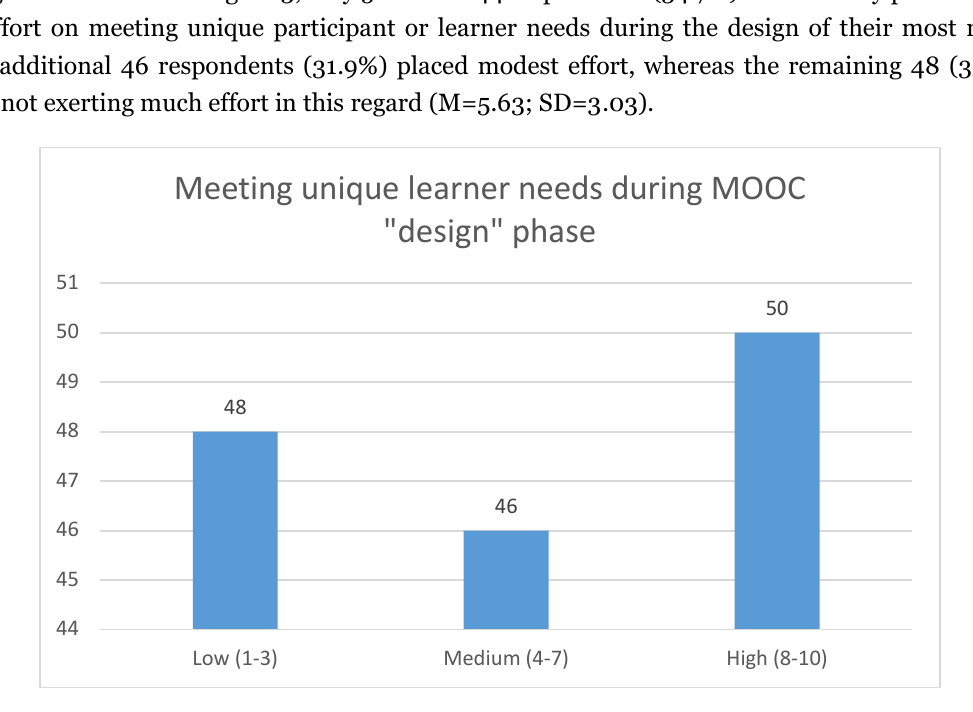
Figure 3 . Effort placed on meeting unique learner needs when designing most recent MOOC. Note: on a scale of 1 (low) to 10 (high)